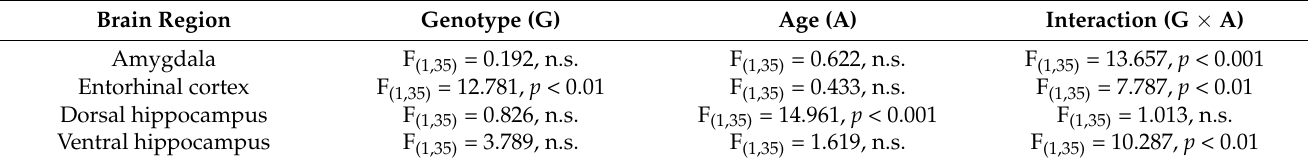
Table 1. Results from the statistical analysis of data obtained from the dot blot